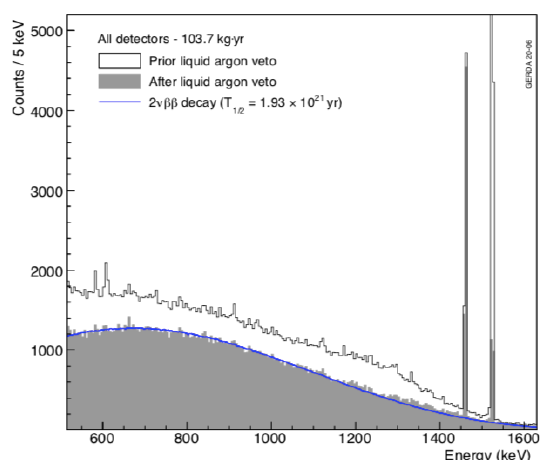
Fig. 1. Energy spectrum measured in GERDA prior (white) and after (grey) LAr veto applied. Both the 40 K and 42 K lines are visible (left/right). The blue line shows the expectation of a pure 2νββ sample indicating the superior performance of the instrumentation.